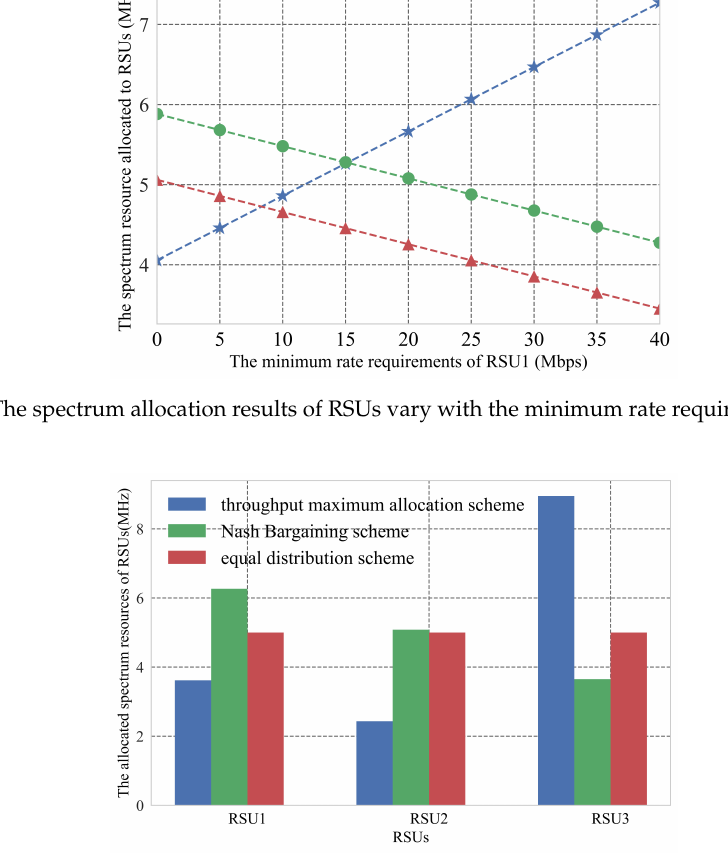
Figure 5. Spectrum resources obtained by RSUs under different distribution